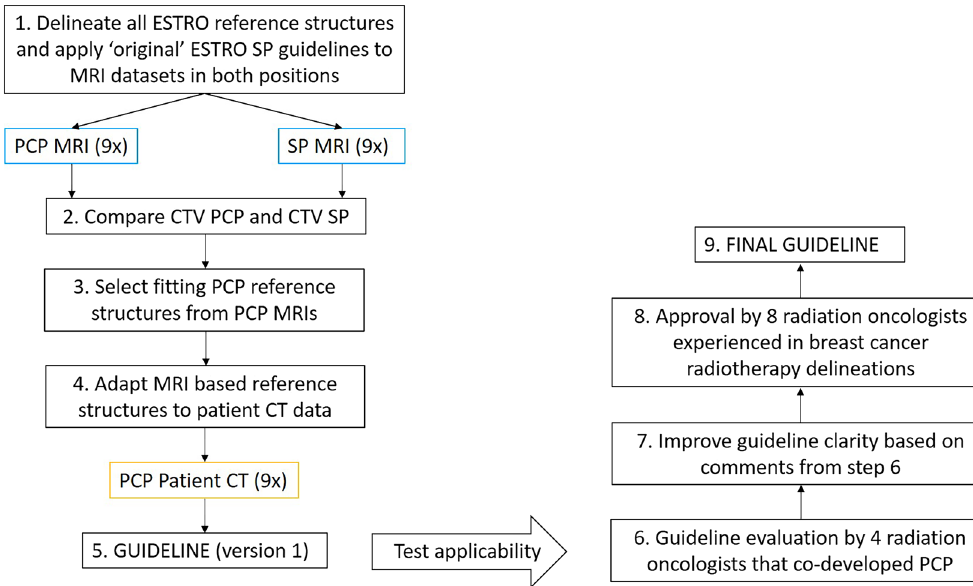
Figure 1. Schematic representation of the guideline development process. SP supine position with arms in elevation, MRI magnetic resonance imaging dataset, CTV clinical target volume, PCP prone crawl position, CT computed tomography dataset. 9 volunteers were MRI scanned in PCP, the same 9 volunteers were also MRI scanned in SP to obtain complementary datasets. 9 (different) patients were scanned to obtain the PCP patient CT